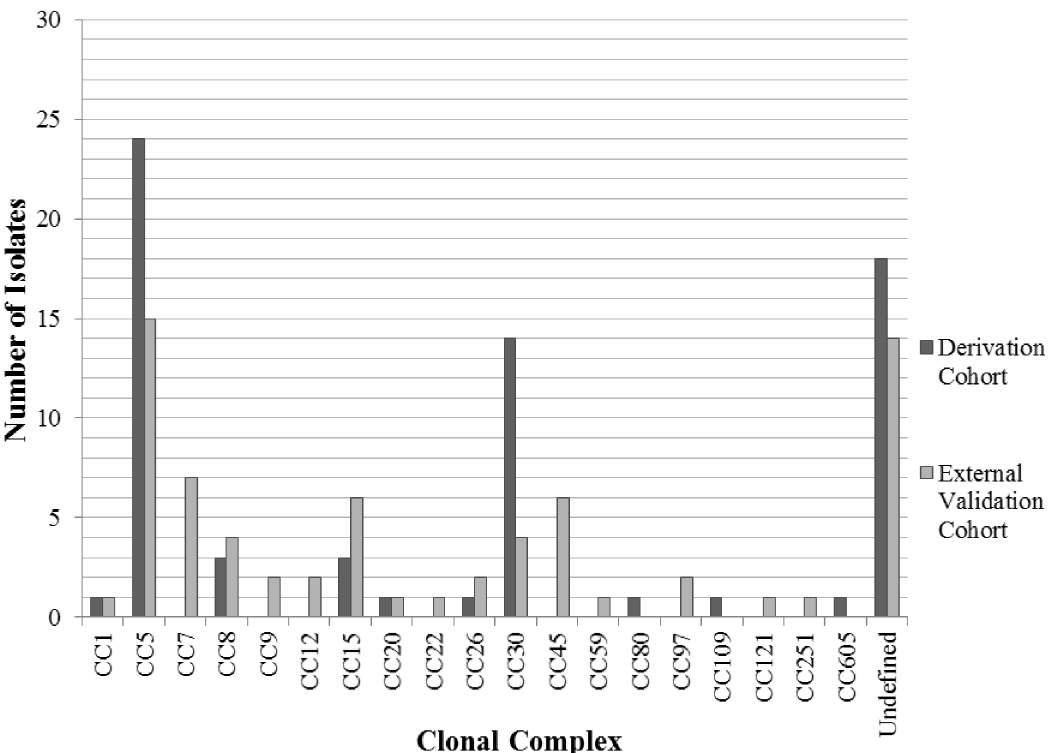
Fig 1. Distribution of clonal complexes amongst S . aureus bloodstream isolates in the derivation and external validation cohorts. Clonal Complex 30 (CC30) was significantly more common in the derivation cohort (p = 0.01), while CC7 and CC45 were significantly more common in the external validation cohort (p = 0.01 and p = 0.03,